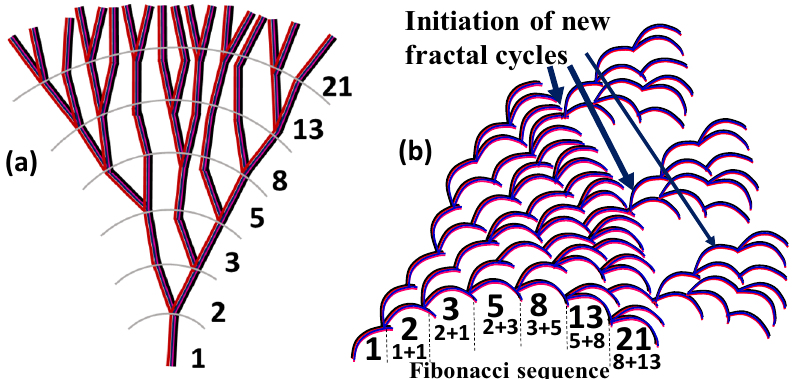
Figure 14. Single-spoke fan in sector-face PLLA spherulites in explosive outward growth based on ( a ) Fibonacci-sequence branching, ( b ) cycles of branching in repetitive growth from front sides of matured